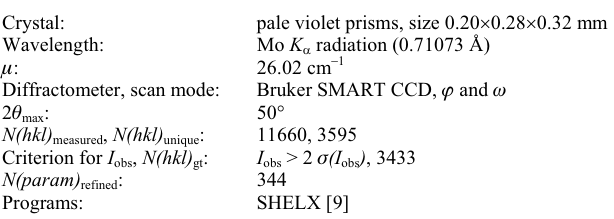
Table 1. Data collection and